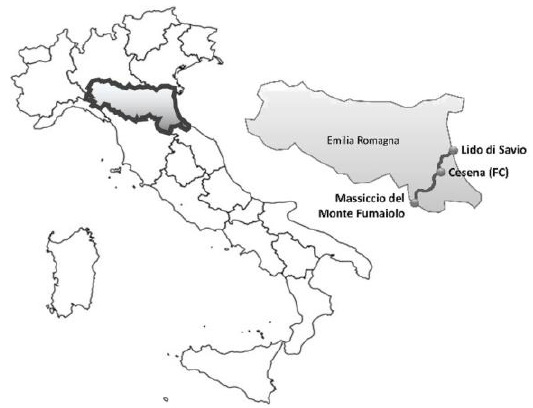
Figure 1. Localization of the Savio river in Emilia-Romagna (Italy)